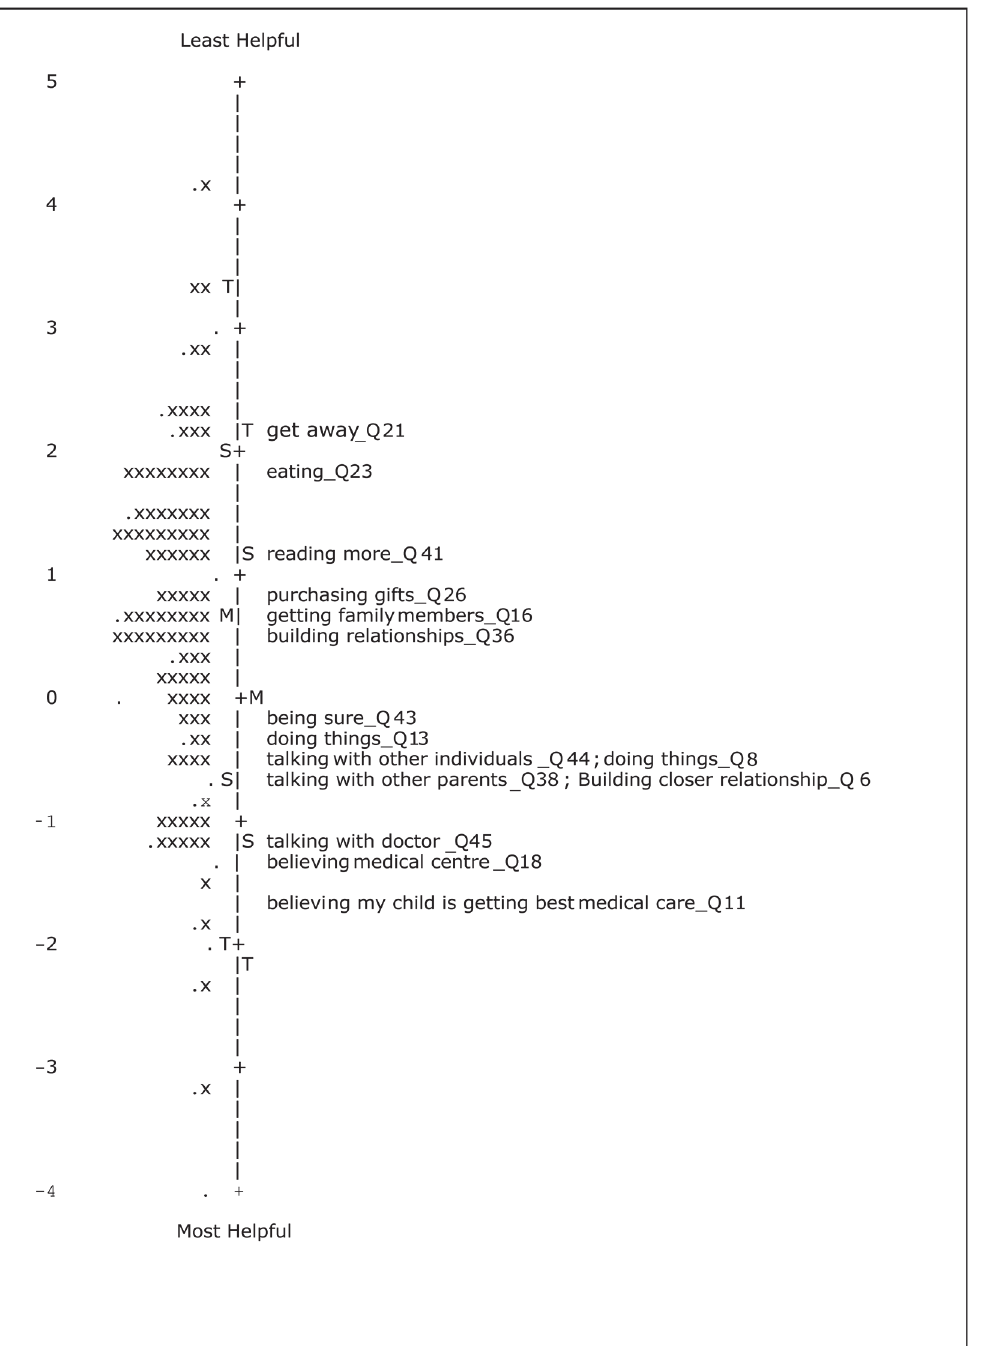
Fig 2. Person-item map for the Rasch-revised 15-item ‘ maintaining family integration, co-operation, and an optimistic definition of the situation ’ subscale of the Coping Health Inventory for Parents (n = 220). Participants are located on the left of the dashed line (represented by ‘ x ’ ) and participants with better coping ability are located at the top of the map. Items (i.e., coping patterns) are on the right of the dashed line with those considered to be least helpful located toward the top of the map. Each ‘ x ’ and “ . ” represent two and one participants respectively. Alongside each item is also indicated its abridged description and number as in the 45-item original CHIP. The complete description of items can be found in Table 2 in the text. M, mean; S, 1 SD from the mean; T, 2 SD from the mean.